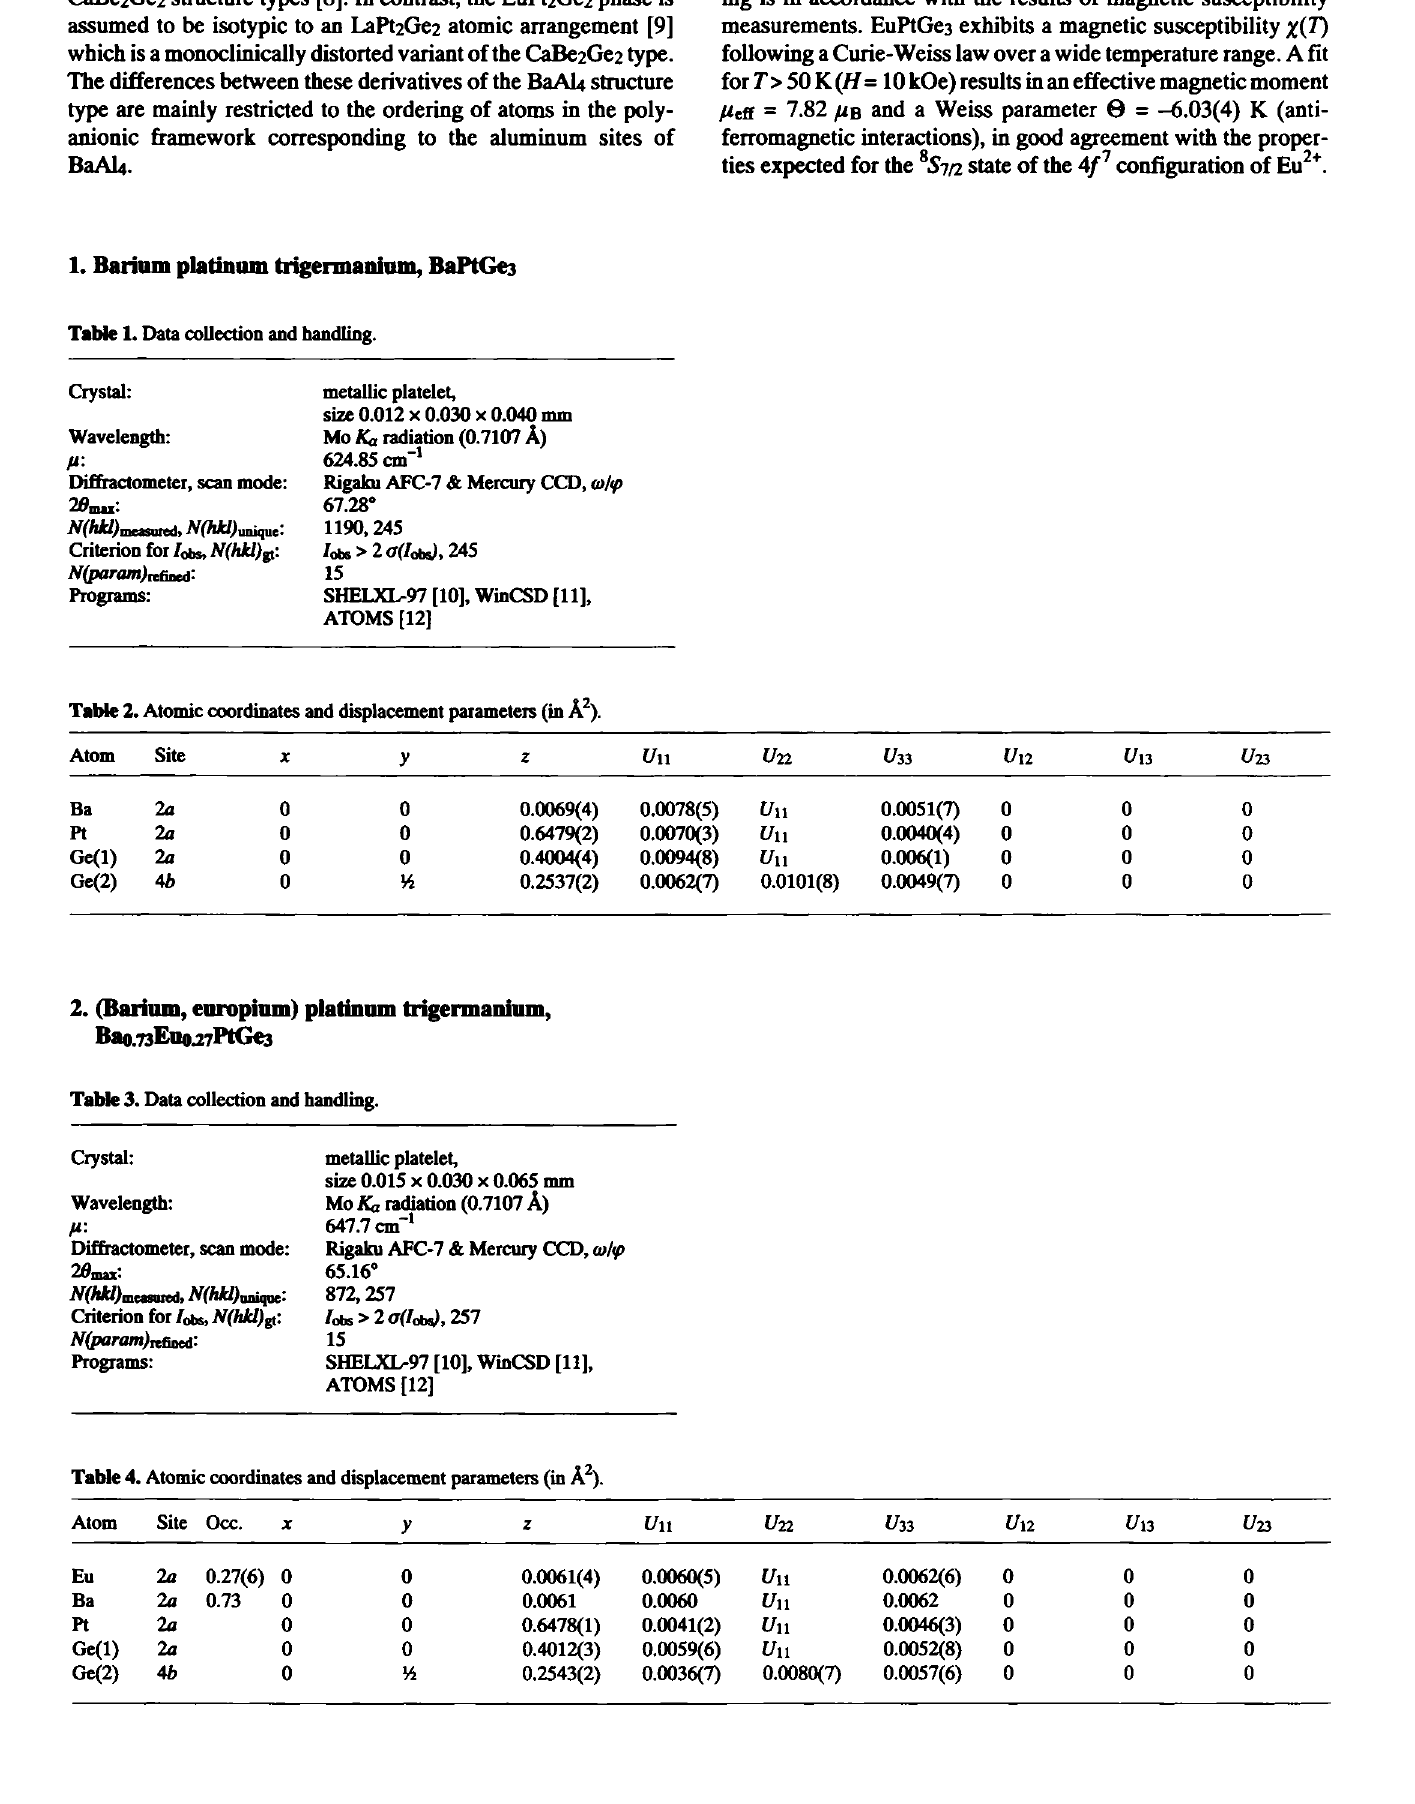
Table 4. Atomic coordinates and displacement parameters (in Ä 2